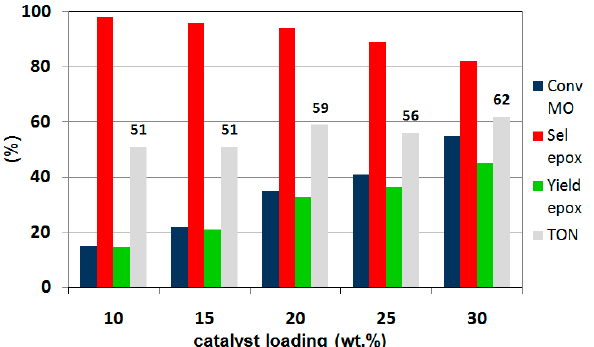
Figure 6. Influence of the mass of NbO x -SiO 2 catalyst (expressed as wt.% with respect to the mass of methyl oleate) on the epoxidation of pure methyl oleate (MO). Conditions: 1 mmol MO, 3 mmol aq. H 2 O 2 , 90 °C, 4 h, 300 rpm, 5 mL CH 3 CN. TON values (turn-over numbers; gray bars) are expressed as moles of MO converted per moles of Nb in the catalyst (in 4 h).